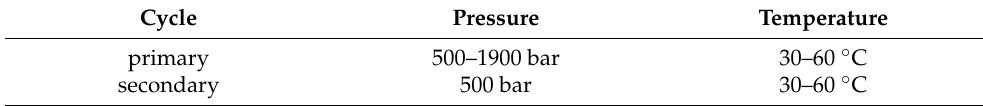
Table 5. Optimal process variables and their settings as control strategy for the two-cycle